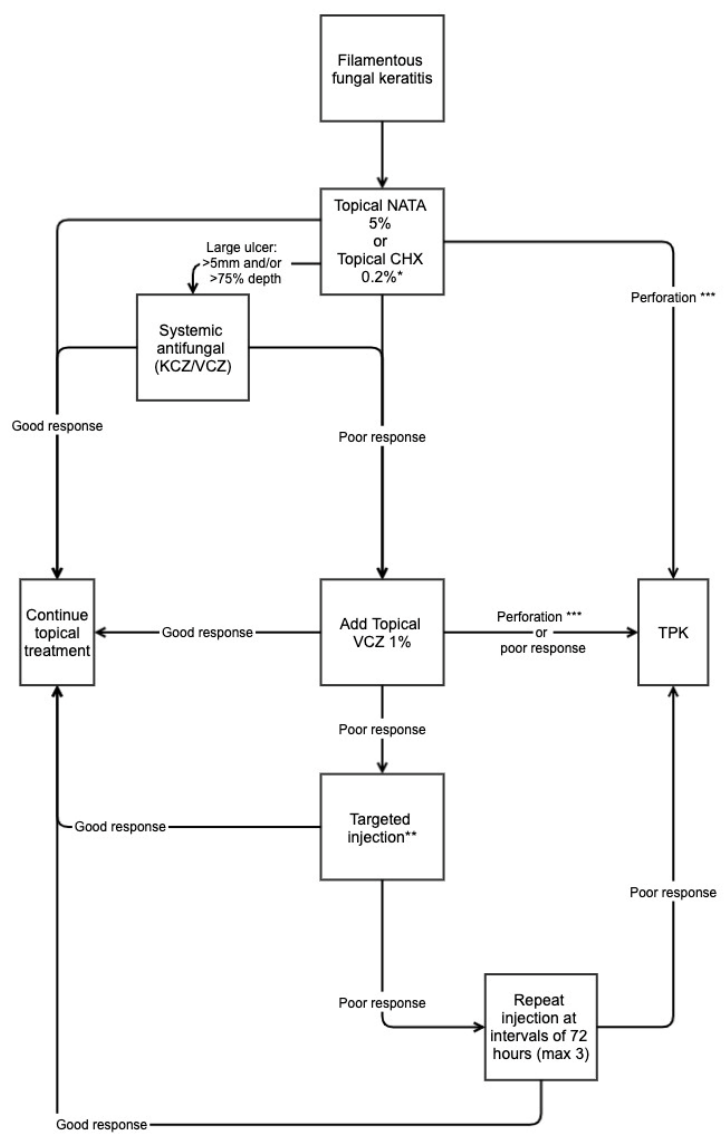
Figure 5. Suggested treatment protocol for filamentous fungal keratitis. * Topical Natamycin 5% is first-line treatment but chlorhexidine 0.2% can be given if natamycin is unavailable. **Targeted in- jection refers to either intrastromal/intracameral voriconazole/amphotericin B. *** Perforation in- cludes descemetocele, impending, and frank corneal perforations. Adapted from the TST Protocol [76].